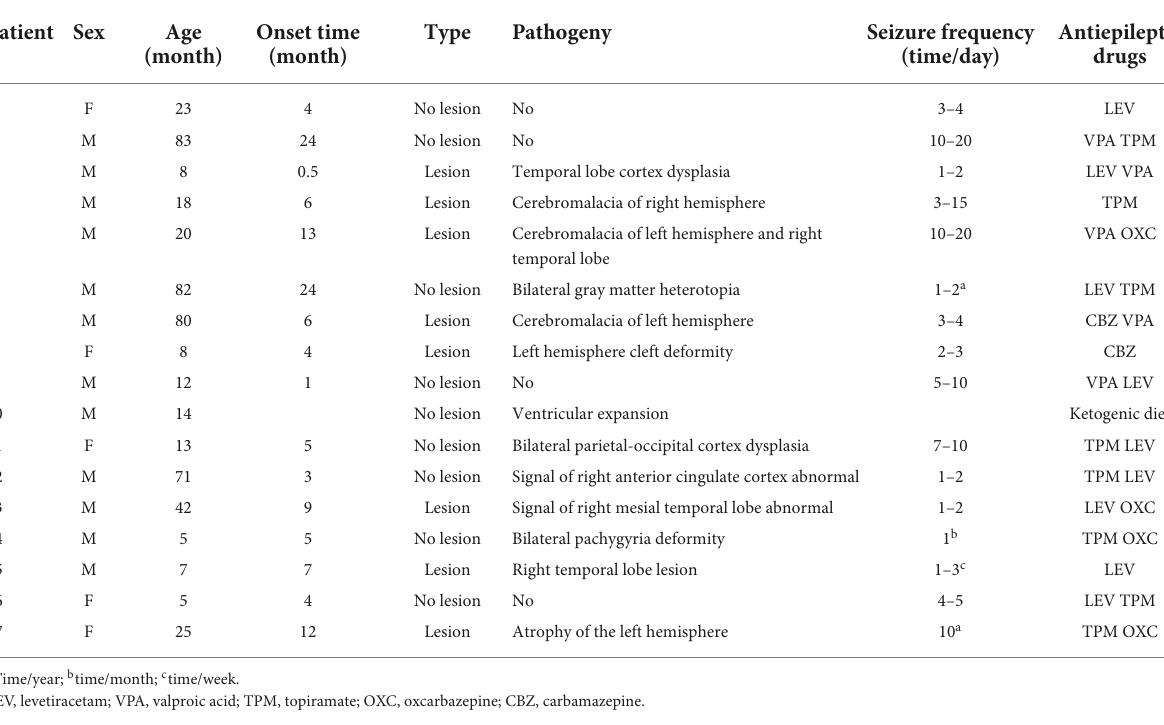
TABLE 1 Characteristics of the IS patients.